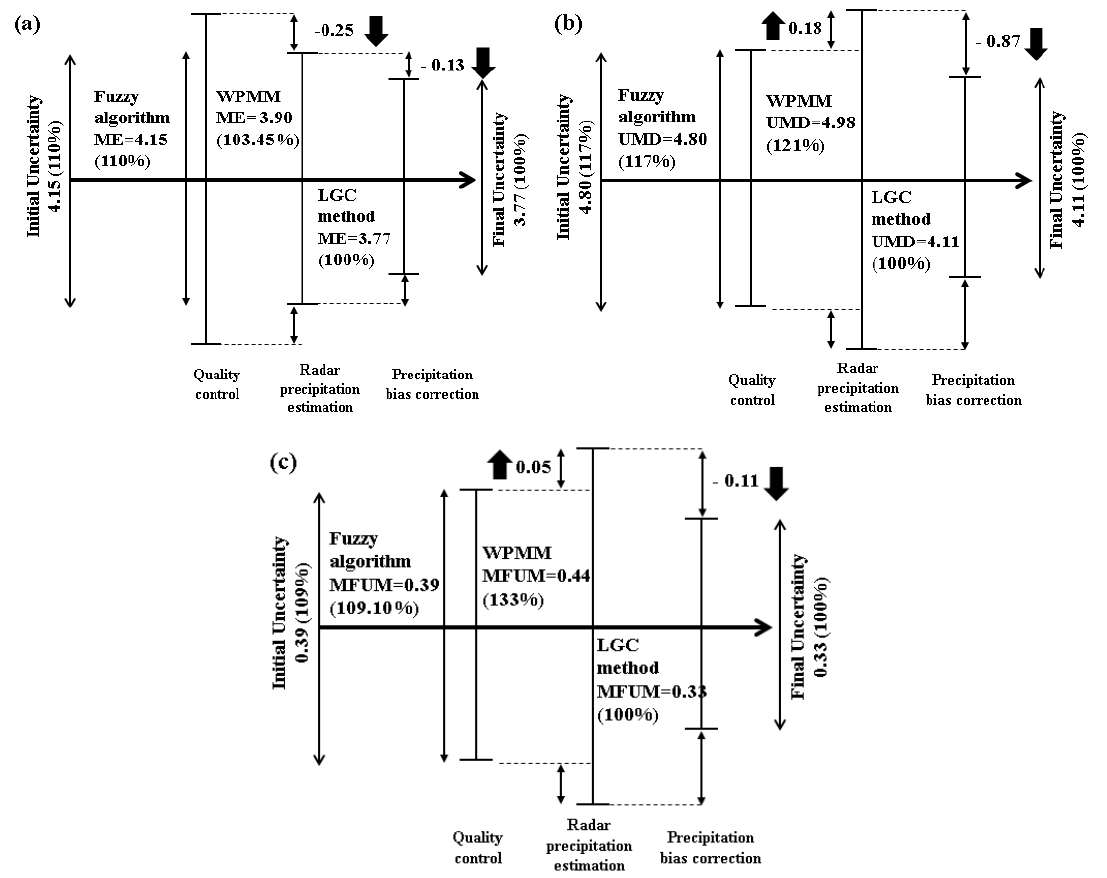
Figure 6. Uncertainty quantification and propagation in the radar-based precipitation estimation